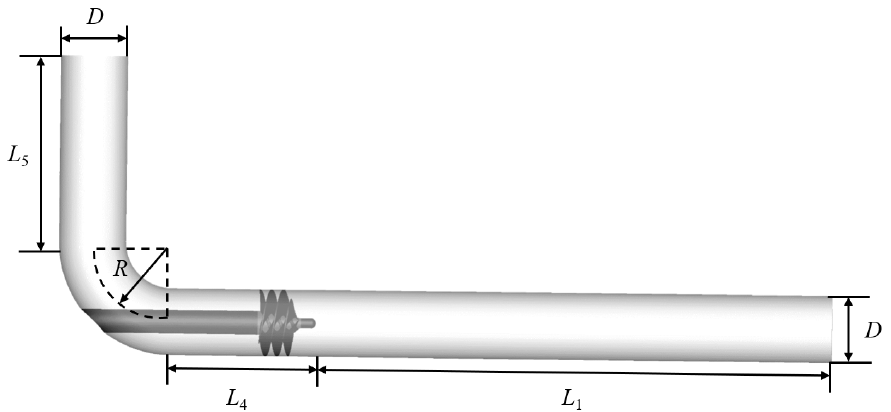
Figure 5. Computational domain of elbow configuration duplicated from the experiment system with the tip clearance of τ = 0.5 mm. L 1 = 800 mm, L 4 = 220 mm, L 5 = 280 mm, D = 101 mm, R = 150